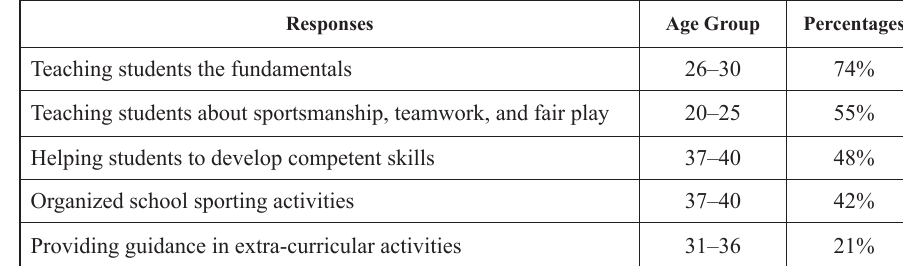
Table 3. PE teachers’ impact on sports in